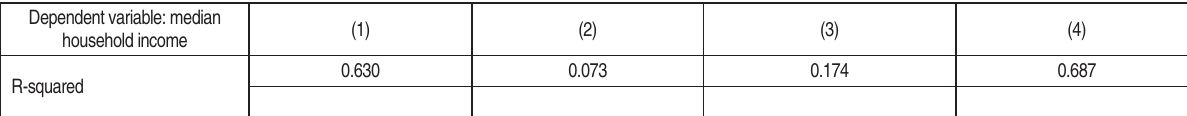
Table 1 (cont.). Influences on median family